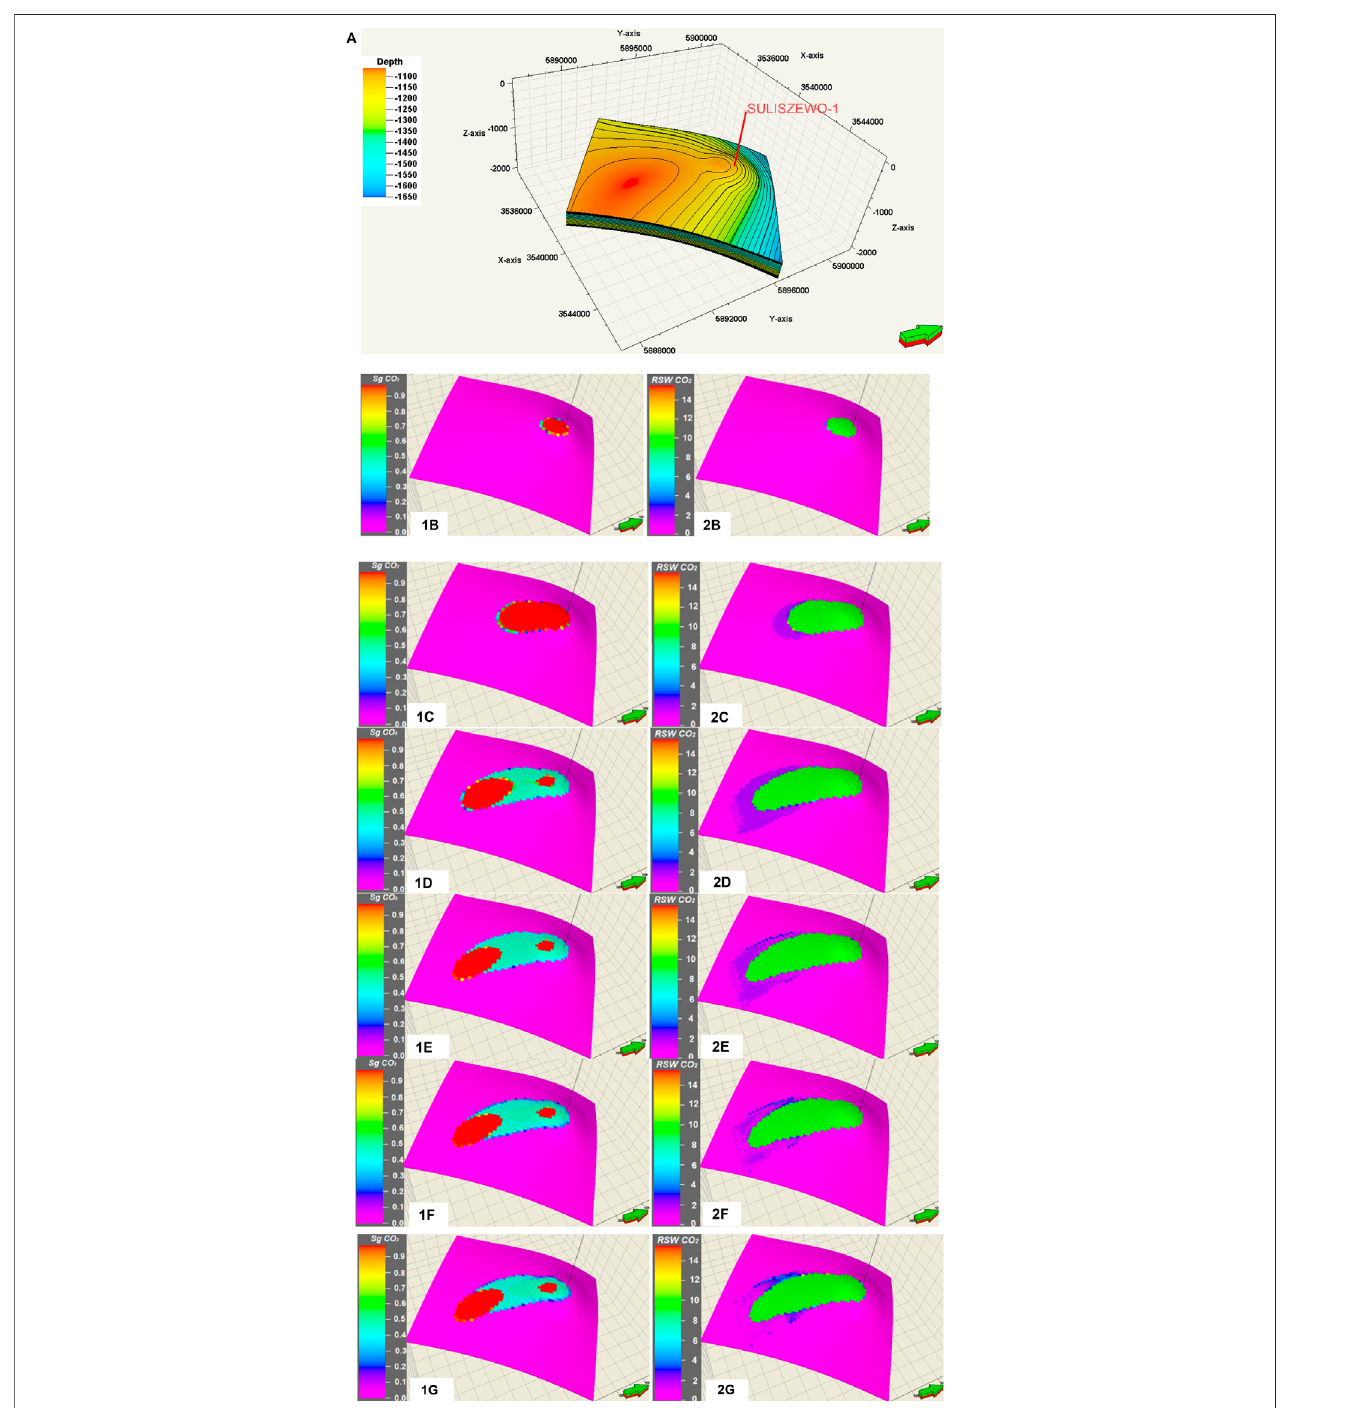
FIGURE7| Determined section enlargedinthefollowingFigures (A) ,thedistribution offreeCO 2 saturation (1) andCO 2 dissolved inbrineRSWCO2-molarfraction (2) in the roof layer of the Pliensbachian collector after (B) 5, (C) 25 years of injection and after (D) 50, (E) 200, (F) 500, (G) 1,000 years after the completion of injection.